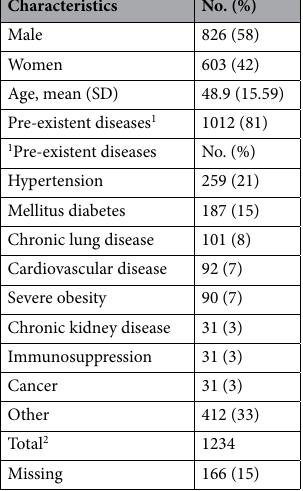
Table 2. Characteristics of Patients Hospitalized with Coronavirus Disease 2019 in Health Centers of Southeast Network. 1 Patients with at least one registered pre-existing disease. 2 Total pre-existing diseases registered, some patients had more than one disease.